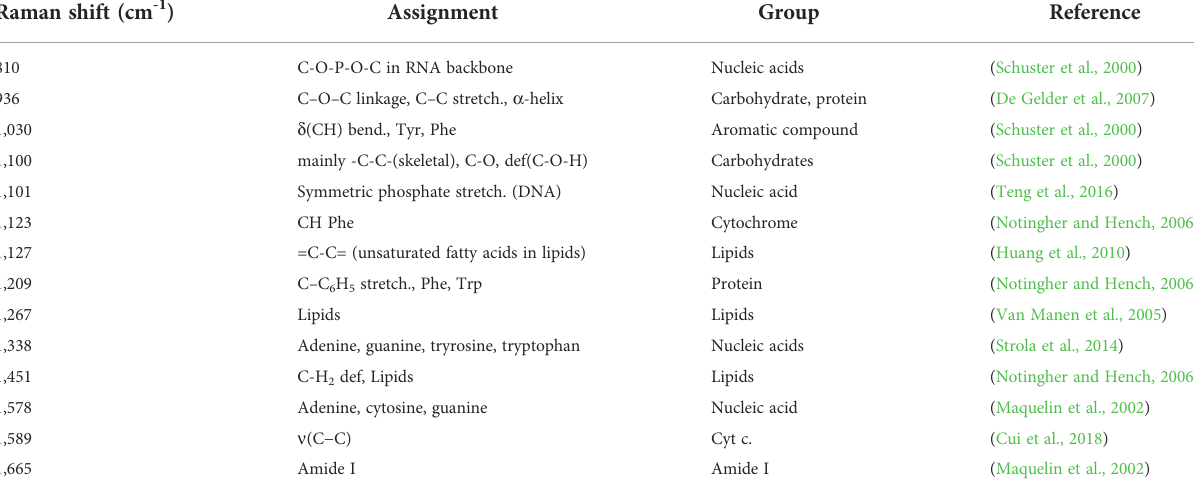
TABLE 2 The Raman frequency of antibiotic-treated samples with signi fi cantly different intensities compared to antibiotic non-treated samples. Raman shift (cm -1 )